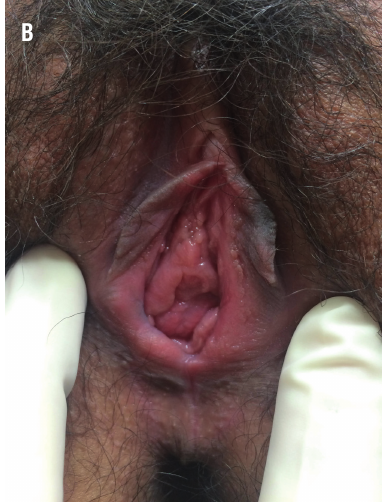
Figure 1 - (a) Multiple HPv lesions on the external genitalia of a 36-year-old female patient; and (b) the HPv lesions disappeared completely after